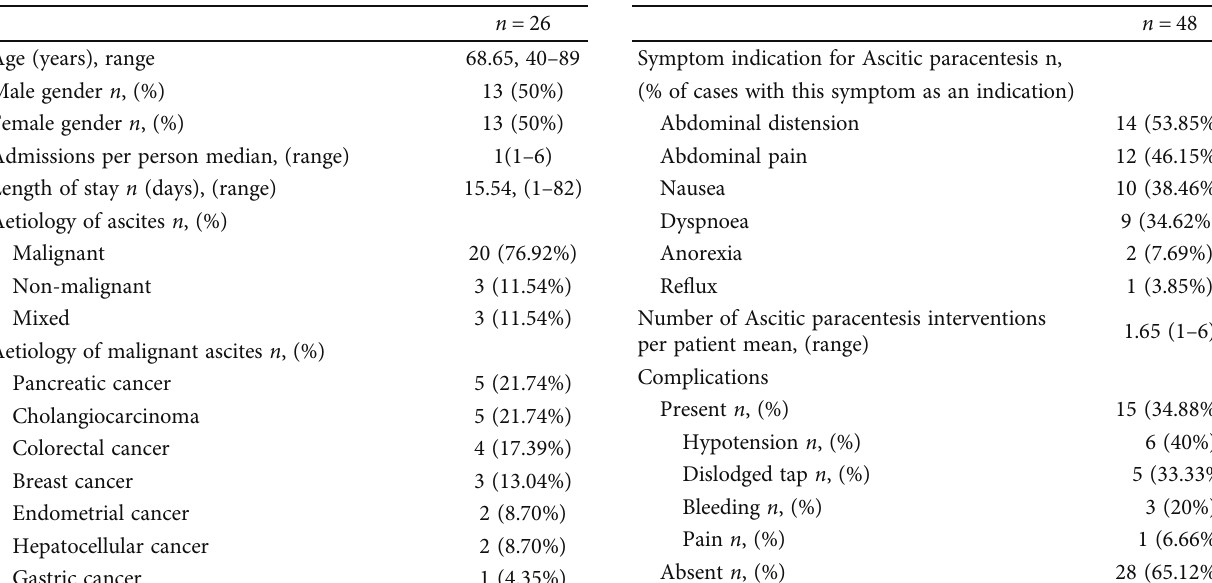
Table 1: Characteristics of patients. Table 2: Details of interventions and